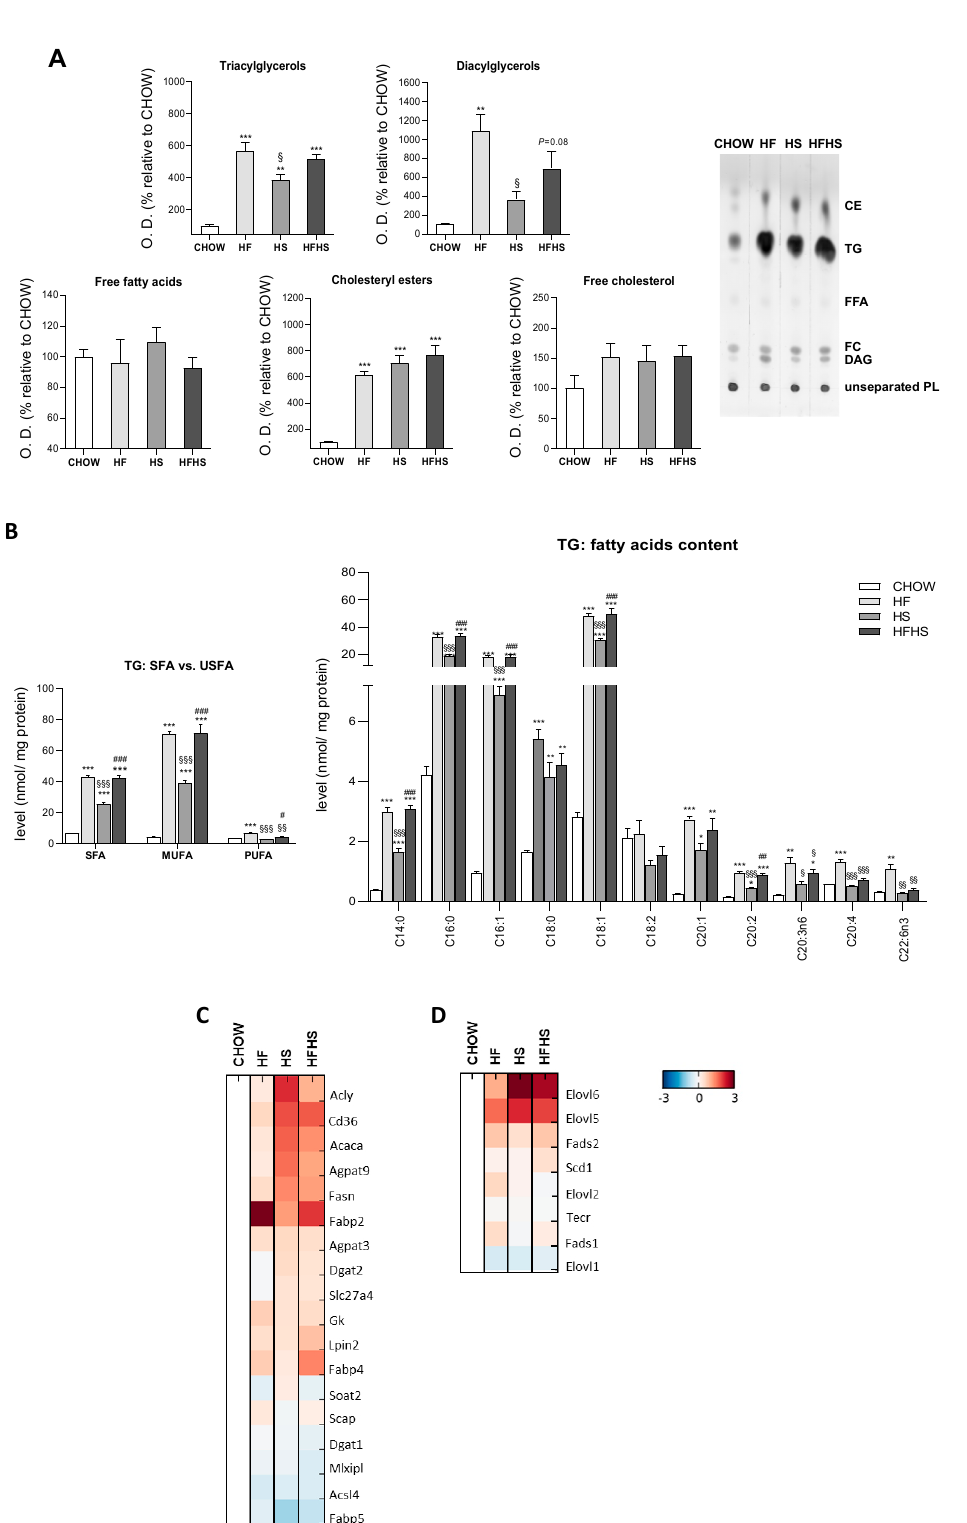
Figure 3. HF, HS and HFHS diets increase hepatic lipid accumulation in the form of TGs enriched in SFAs and MUFAs. ( A ) Optical density (arbitrary units) of hepatic tissue content of TGs, diacylglycerols, free FAs, CEs and free cholesterol and representative thin-layer chromatography image of a replicate showing all neutral lipid species ( N = 4). ( B ) Levels of SFAs, MUFAs and PUFAs in the hepatic